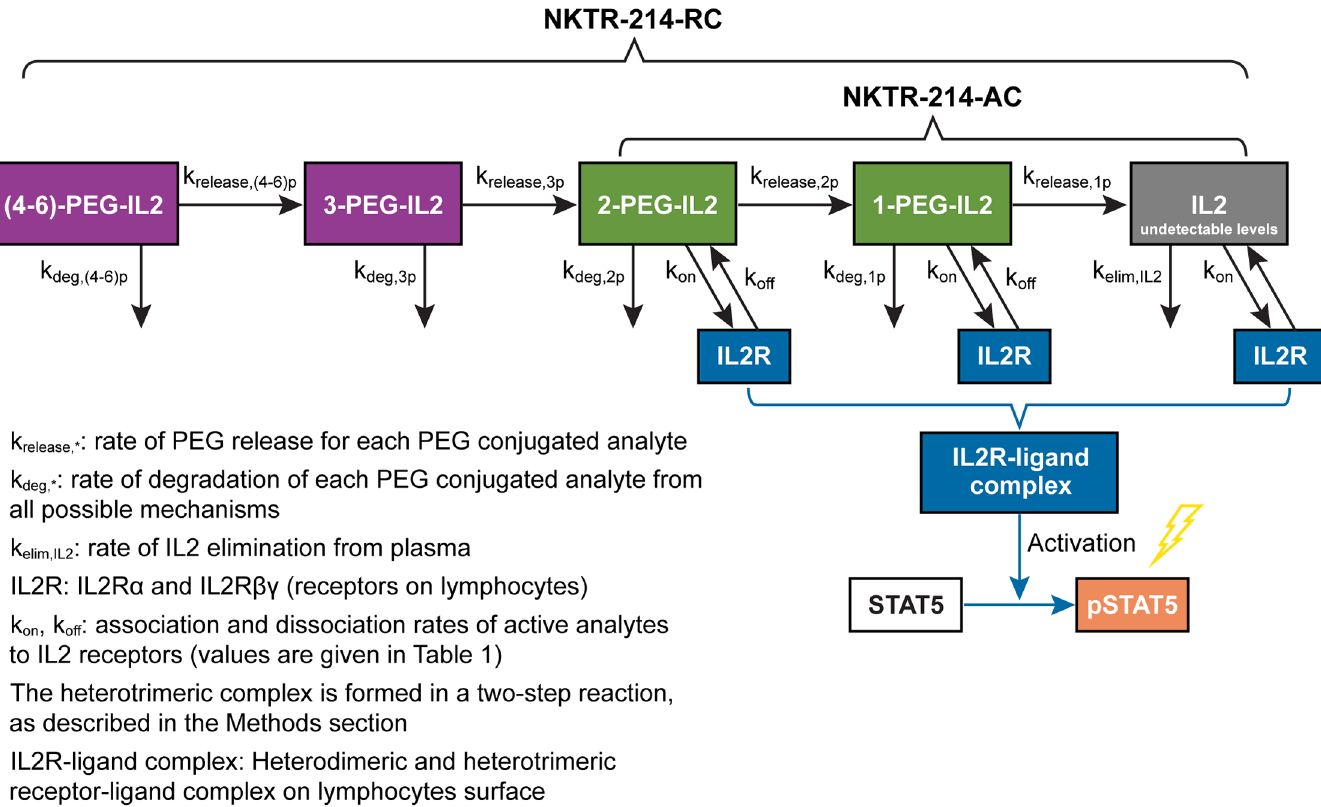
Fig 2. Parameterization of the mathematical model for NKTR-214dynamics to simulate concentration-time profiles of conjugated-IL2 species derived from NKTR-214and to describe receptor occupancy of the conjugated-IL2 species at the IL2R αβγ and IL2R βγ .